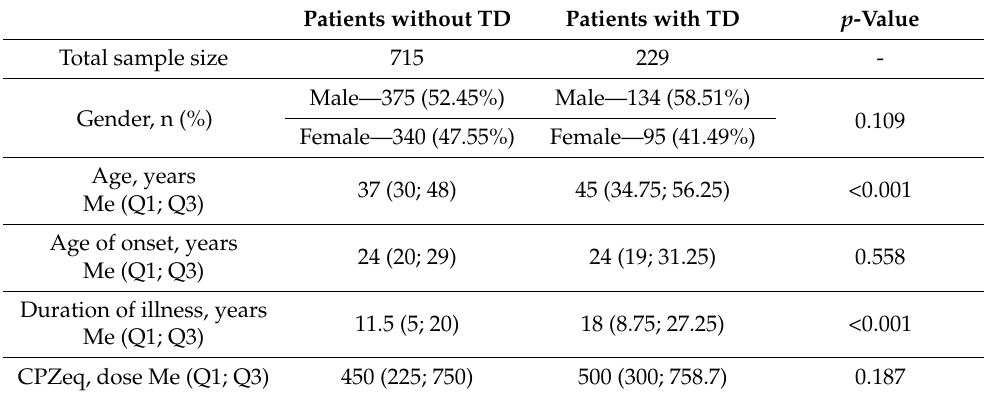
Table 2. Demographic and clinical parameters of the total group of patients with schizophrenia depending on the presence or absence of tardive dyskinesia.